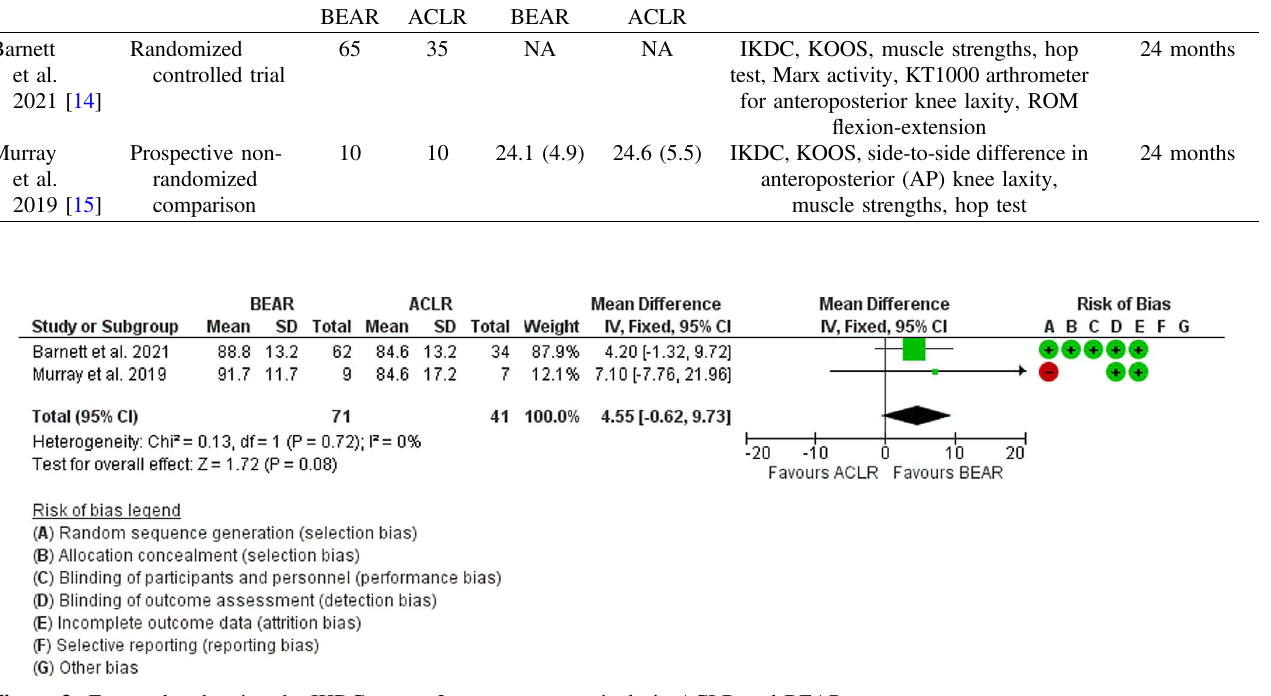
Figure 3. Forest plot showing the IKDC scores 2 years postoperatively in ACLR and BEAR.